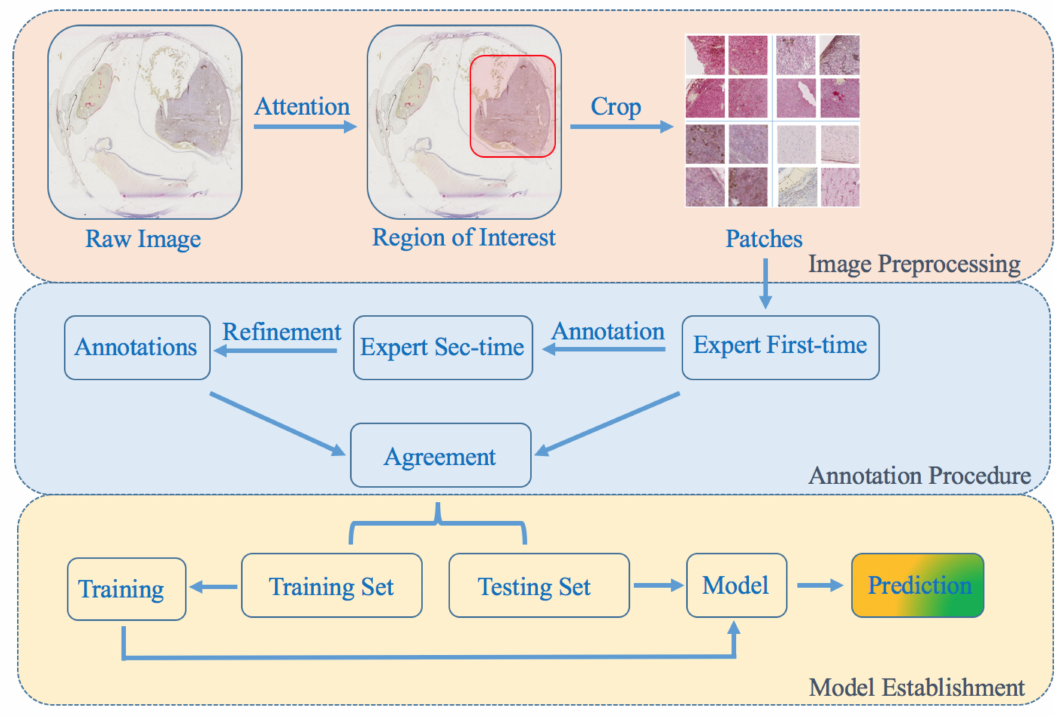
Figure 2. The data flow in our research. First, the raw images were cropped into patches. Second, the patches were finely annotated through two steps by an ophthalmic pathologist. Finally, the dataset was separated into two subsets and fed into the network for training and